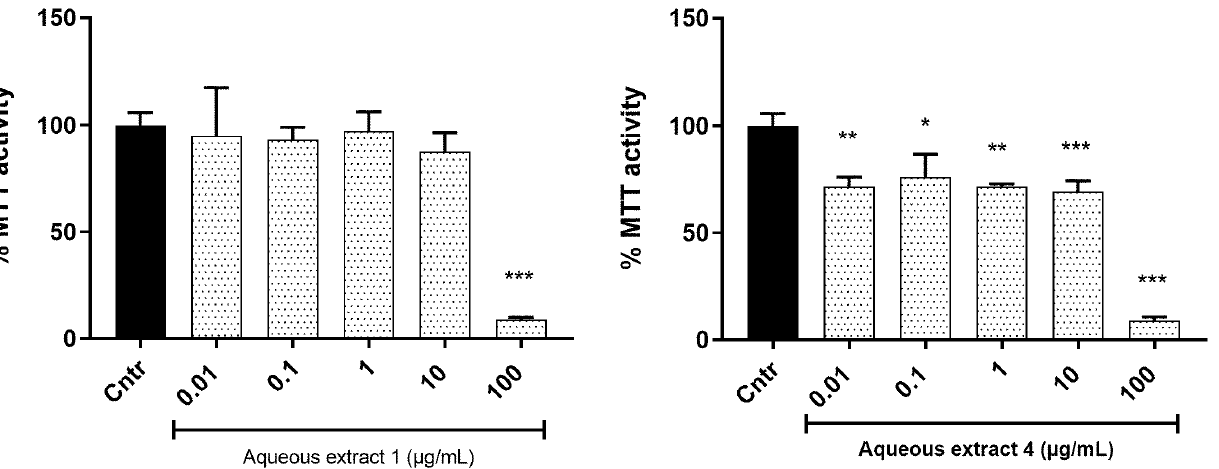
Figure 2. MTT cell viability assay of C2C12 myocytes treated with extract for 72 h. The data are presented as mean ± SD, expressed relative to the control at 100%. p value, * p < 0.05, ** p < 0.01, *** p < 0.001.